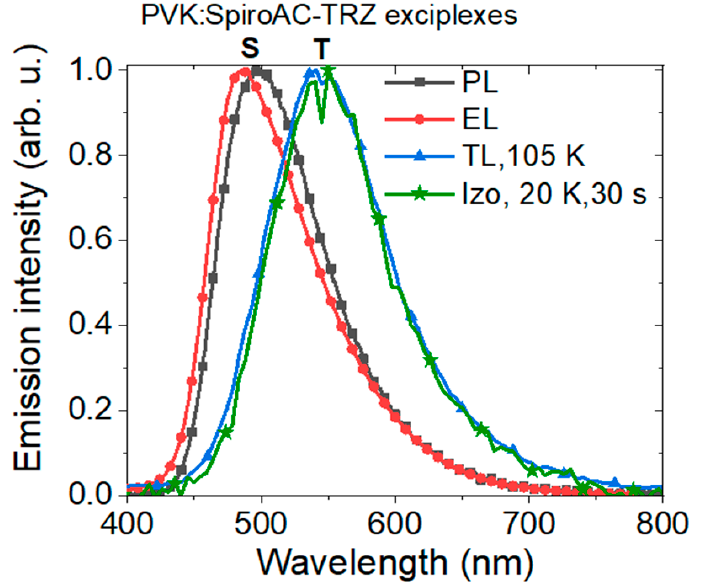
Figure 11. Spectra of PVK + 25 wt% SpiroAC–TRZ recorded during PL, EL and TL experiments. The temperature is a critical factor for the radiative recombination mechanisms ob- served in EL and TL phenomena. During the optical excitation at low temperature (TL experiment), part of the generated electron–hole pairs is trapped on various kinds of species but mostly on formed exciplexes. Only when thermal energy is delivered to the sample are the charge carriers released from the traps and next, can directly recombine radiatively by the intersystem crossing or created excitons can be transferred on other species (molecules). On the contrary, in the electroluminescence phenomenon, at room temperature, the singlet states act as radiative recombination centers, whereas triplet exci- plexes preferably operate as transport and/or trapping centers with an extremely short time of charge carriers stay. Such a mechanism could be proposed for PVK:PBD.